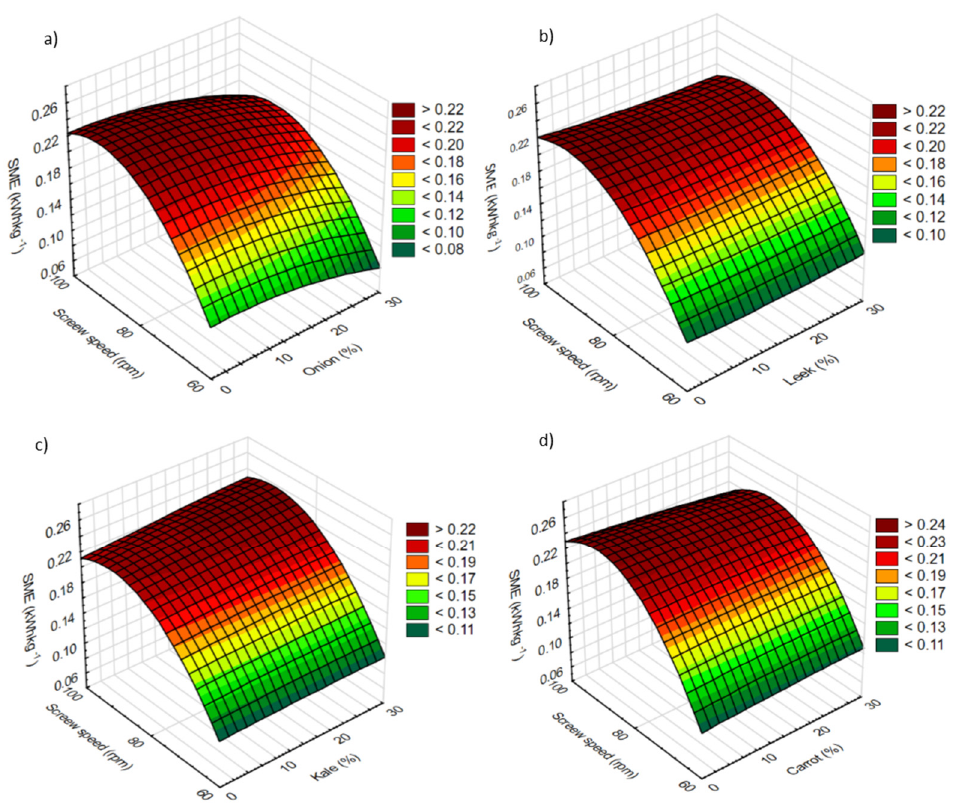
Figure 3. Response plots of the effect of processing variables on specific mechanical energy during extrusion-cooking of potato-based snack pellets with addition of fresh vegetables: ( a ) carrot, ( b ) kale, ( c ) leek and ( d ) onion.